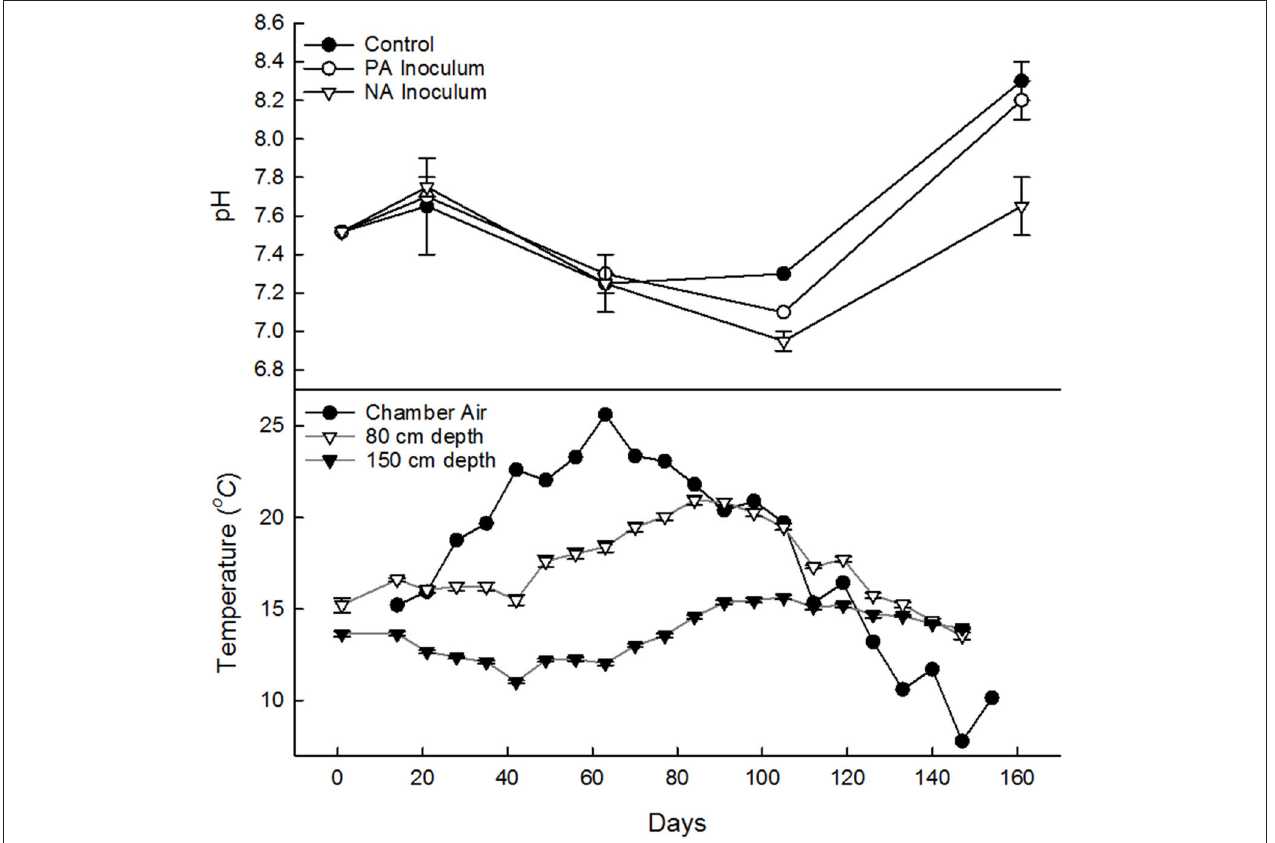
FIGURE 1 | Manure pH (top) in control (•), previously acidified (PA) inoculum ( ◦ ), and newly acidified (NA) inoculum treatments ( ∇ ), samples from on May 29 from fresh manure and stored manure on June 15, July 27, Sept 8, and Oct 2018 (7, 49, 92, and 155 days). Weekly average temperature (bottom) averaged across all tanks, of chamber air 10cm (•) above manure and of manure at 80cm ( ∇ ) and 150cm ( H ) depth. Error bars denote standard